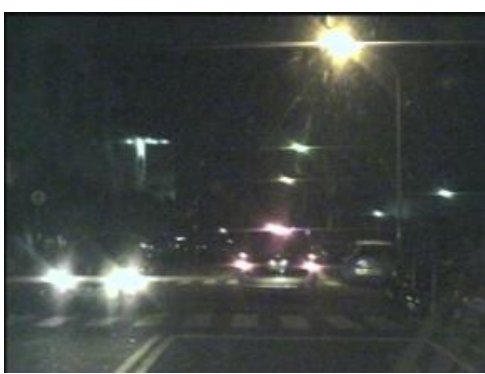
Figure 2. A sample nighttime road scene.